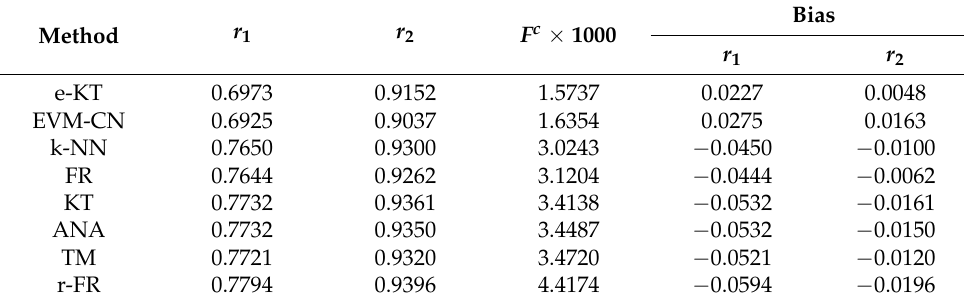
Table 19. Reactivity ratios obtained in the imposed conditions of HC2.